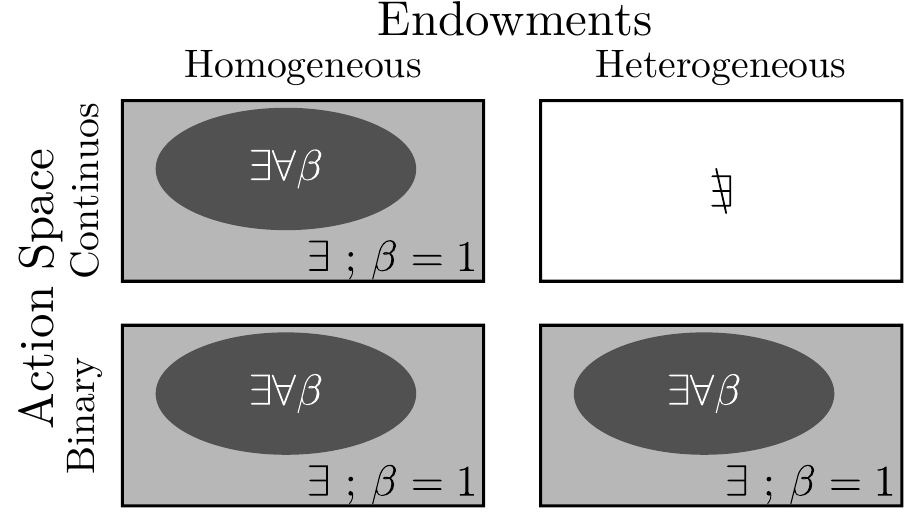
Figure 2. The figure summarizes the existence of the “high-efficiency” equilibria described in this section. For homogeneous endowments, regardless of the action space, there exist high contribution equilibria for high enough marginal rates of return. In the case of heterogeneous endowments, only a binary action space allows for contributive equilibria. Whenever high contribution equilibria exist under full meritocracy, there exists a marginal rate of return (higher than the one for β = 1) such that the high equilibria exist also with a fuzzy